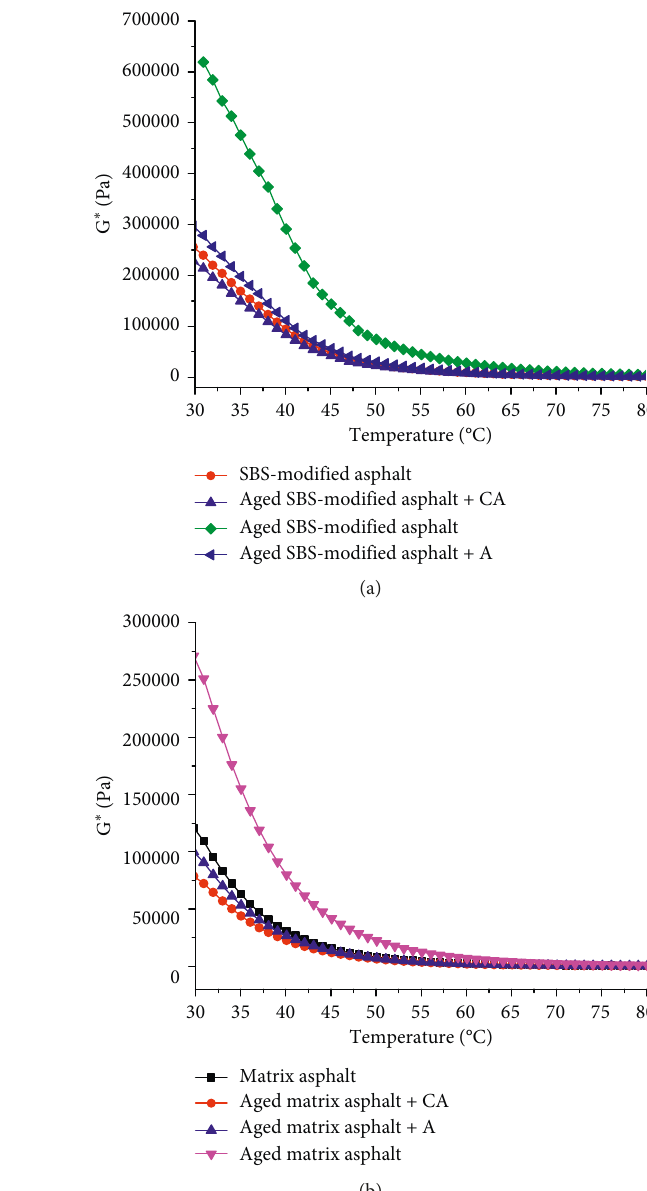
Figure 7: G ∗ variation before and after asphalt recycling: (a) SBS- modified asphalt; (b) matrix